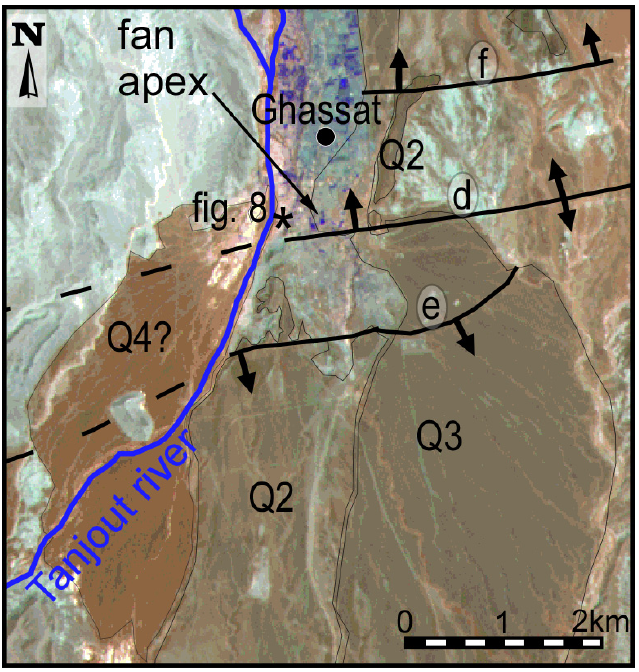
Figure 9. Map of the Quaternary deposits and surface flexures in the Tanjout area, on an ASTER image extract. South of Ghassat, an alluvial fan is sourced on the structure